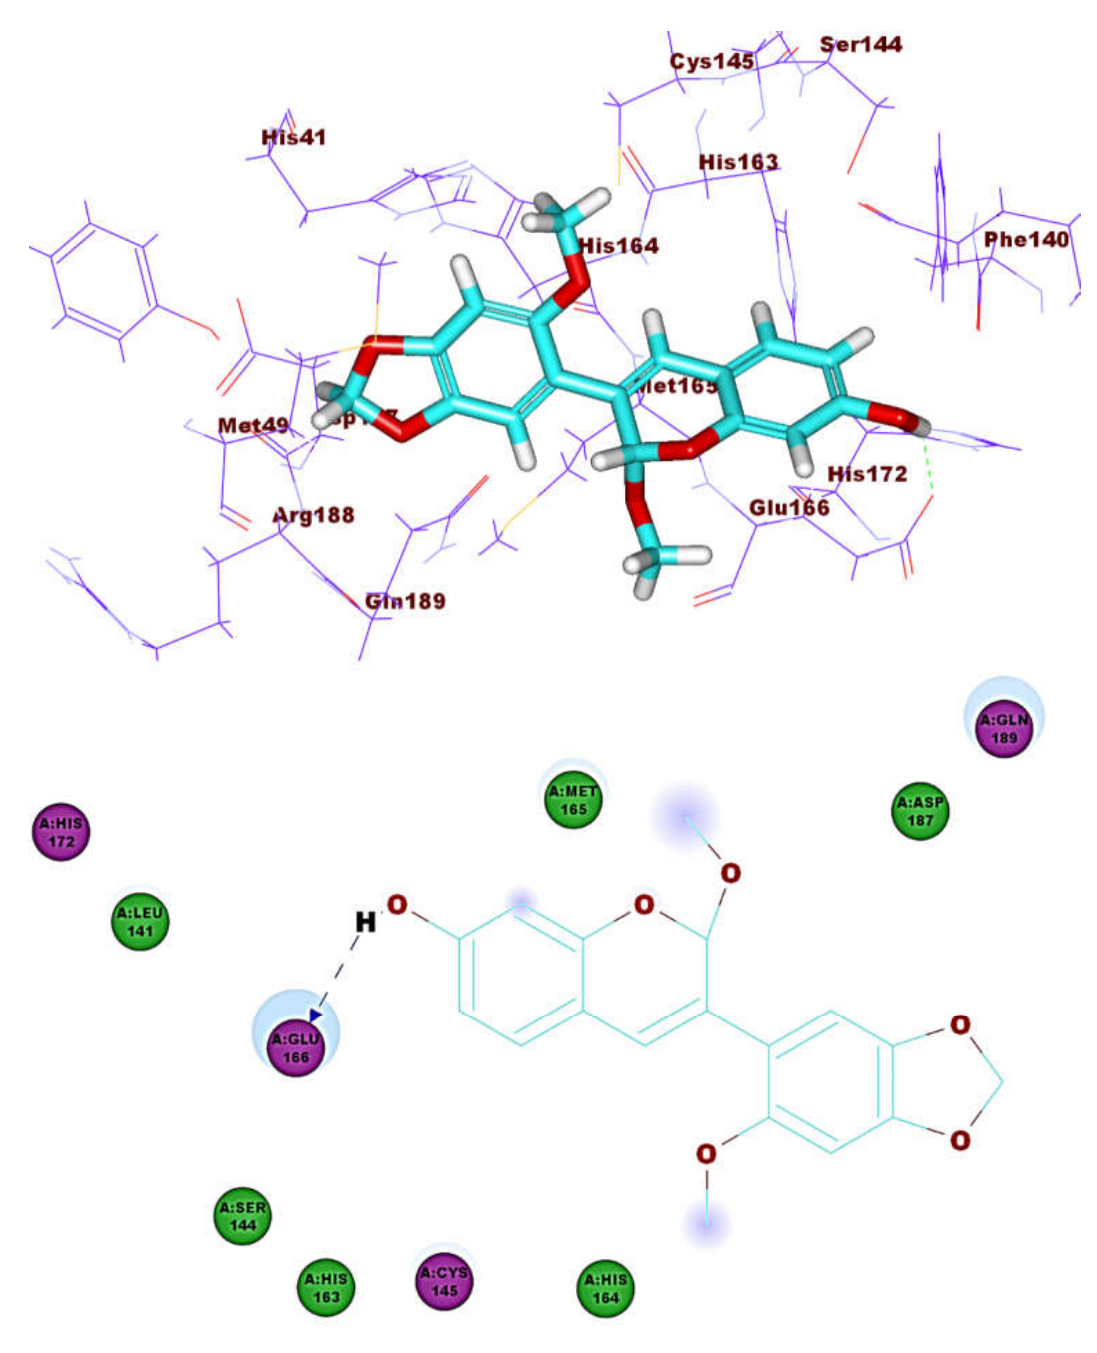
Figure 11. Compound 7 docked into M pro , forming one H. bond with Glu166.